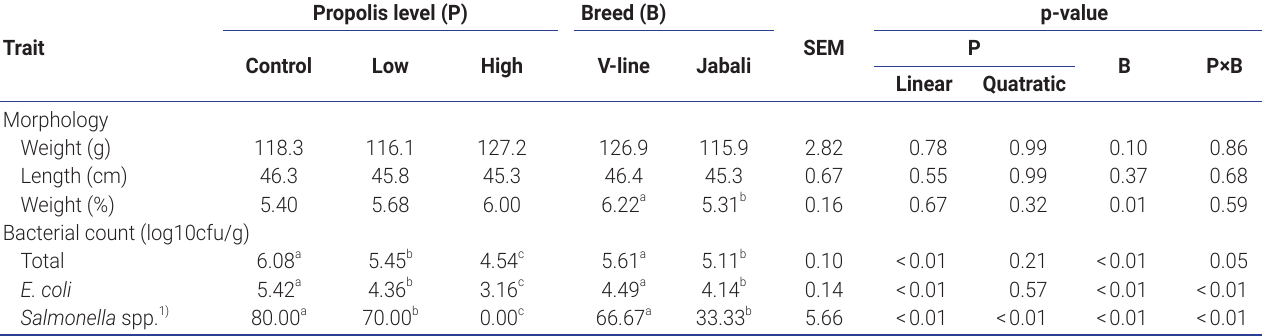
Table 5. Effect of propolis and breed on cecal morphology and microbiota in rabbits